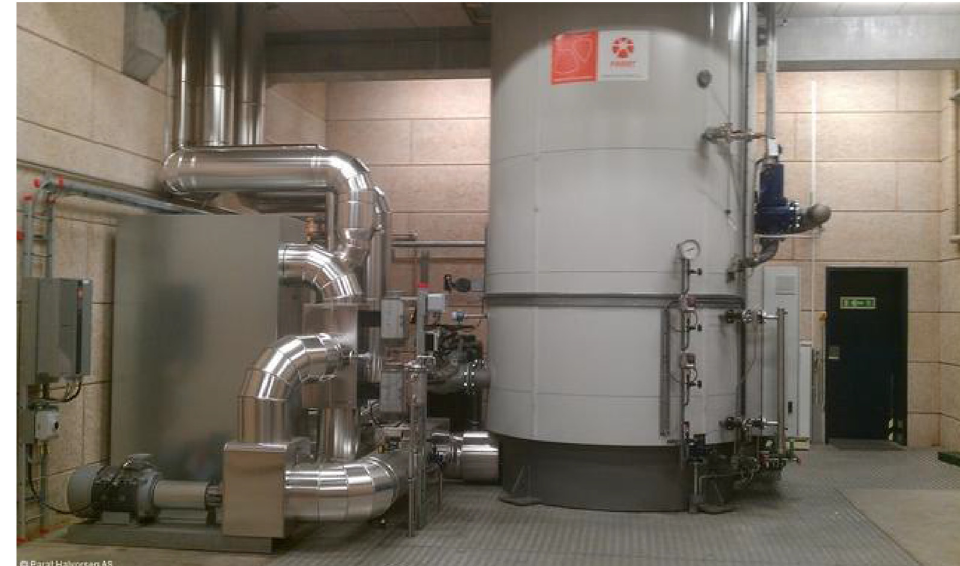
Figure 13. Example of an installed 10 MW electrode boiler from Parat in Denmark.